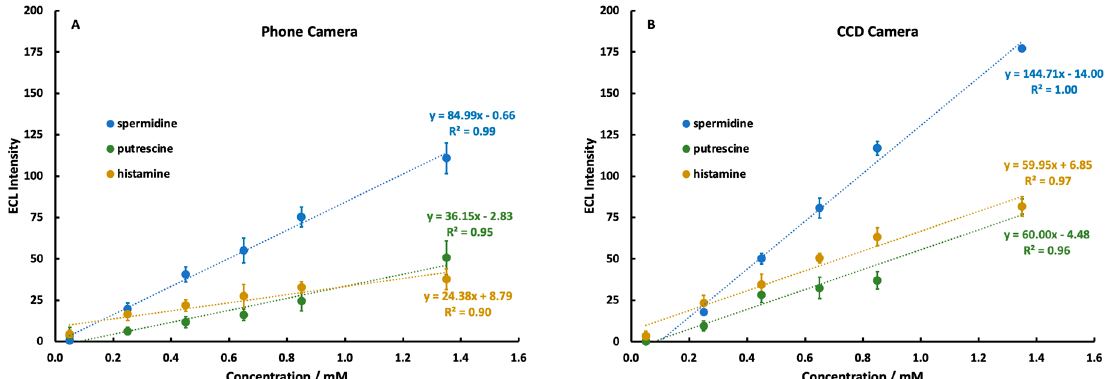
Figure 6. Background-subtracted calibration curves for 0.05–1.35 mM spermidine, putrescine, and histamine added to 5.0 mM Ru(bpy) 32+ , detected by a Samsung Galaxy S7 Edge phone camera ( A ) and a CCD Camera ( B ). Each curve is the average of 3 separate studies on independent electrodes, and each study was n = 5 at every concentration. Table 1. Mobile Phone and CCD Limits of Detection, Linear Range and Precision for Biogenic Amine ECL.